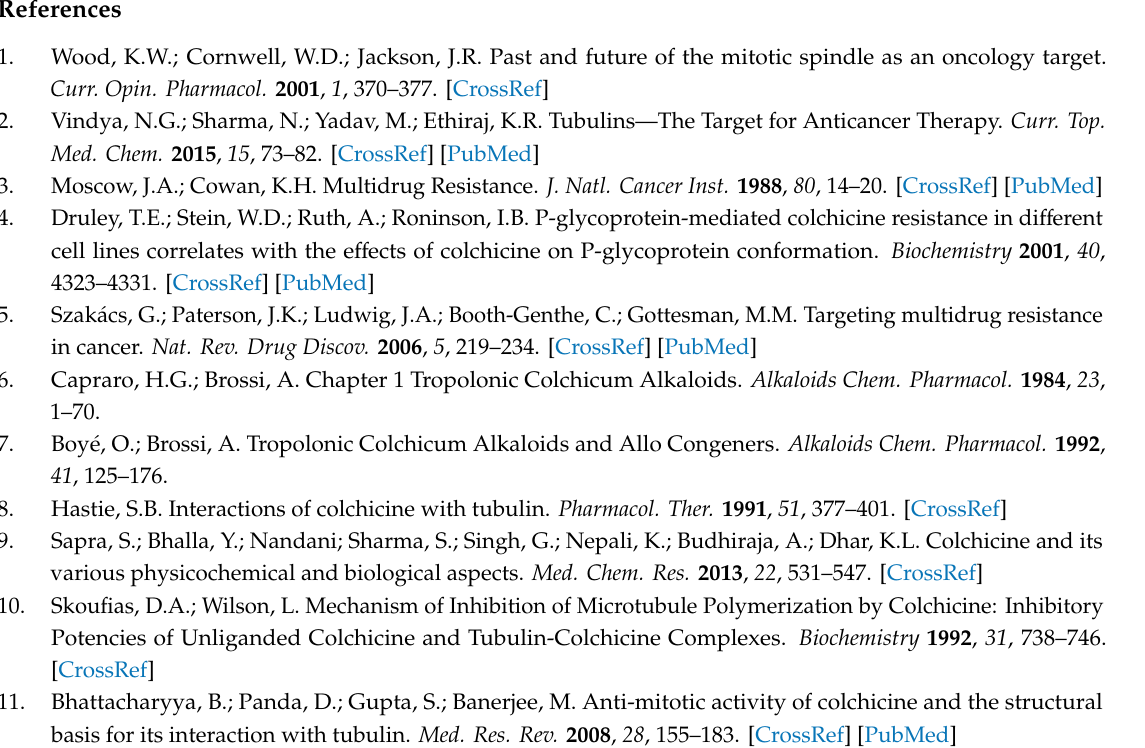
and mass spectra of 2 , Figure S2: The 1 H NMR spectrum of 2 in CDCl 3 , Figure S3: The 13 C NMR spectrum of 2 in CDCl 3 , Figure S4: The LC-MS chromatogram and mass spectra of 3 , Figure S5 : The 1 H NMR spectrum of 3 in CDCl 3 , Figure S6: The 13 C NMR spectrum of 3 in CDCl 3 , Figure S7: The LC-MS chromatogram and mass spectra of 4, Figure S8 : The LC-MS chromatogram and mass spectra of 5 , Figure S9: The 1 H NMR spectrum of 5 in CDCl 3 , Figure S10: The 13 C NMR spectrum of 5 in CDCl 3 , Figure S11: The LC-MS chromatogram and mass spectra of 6 , Figure S12: The 1 H NMR spectrum of 6 in CDCl 3 , Figure S13: The 13 C NMR spectrum of 6 in CDCl 3 , Figure S14: The LC-MS chromatogram and mass spectra of 7 , Figure S15: The 1 H NMR spectrum of 7 in CDCl 3 , Figure S16: The 13 C NMR spectrum of 7 in CDCl 3 , Figure S17: The LC-MS chromatogram and mass spectra of 8 , Figure S18:The 1 H NMR spectrum of 8 in CDCl 3 , Figure S19: The 13 C NMR spectrum of 8 in CDCl 3 , Figure S20: The LC-MS chromatogram and mass spectra of 9 , Figure S21: The 1 H NMR spectrum of 9 in CDCl 3 , Figure S22: The 13 C NMR spectrum of 9 in CDCl 3 , Figure S23: The LC-MS chromatogram and mass spectra of 10 , Figure S24: The 1 H NMR spectrum of 10 in CDCl 3 , Figure S25: The LC-MS chromatogram and mass spectra of 11 , Figure S26: The 1 H NMR spectrum of 11 in CD 2 Cl 2 , Figure S27: The 13 C NMR spectrum of 11 in CD 2 Cl 2 , Figure S28: The LC-MS chromatogram and mass spectra of 12 , Figure S29: The 1 H NMR spectrum of 12 in CDCl 3 , Figure S30: The 13 C NMR spectrum of 12 in CDCl 3 , Figure S31: The LC-MS chromatogram and mass spectra of 13 , Figure S32: The 1 H NMR spectrum of 13 in CDCl 3 , Figure S33: The 13 C NMR spectrum of 13 in CDCl 3 , Figure S34: The LC-MS chromatogram and mass spectra of 14 , Figure S35: The 1 H NMR spectrum of 14 in CDCl 3 , Figure S36: The 13 C NMR spectrum of 14 in CDCl 3 , Figure S37: The LC-MS chromatogram and mass spectra of 15 , Figure S38: The 1 H NMR spectrum of 15 in CDCl 3 , Figure S39: The 13 C NMR spectrum of 15 in CDCl 3 , Figure S40: The LC-MS chromatogram and mass spectra of 16 , Figure S41: The 1 H NMR spectrum of 16 in CD 3 CN, Figure S42: The 13 C NMR spectrum of 16 in CD 3 CN, Figure S43: The LC-MS chromatogram and mass spectra of 17 , Figure S44: The 1 H NMR spectrum of 17 in CDCl 3 , Figure S45: The 13 C NMR spectrum of 17 in CDCl 3